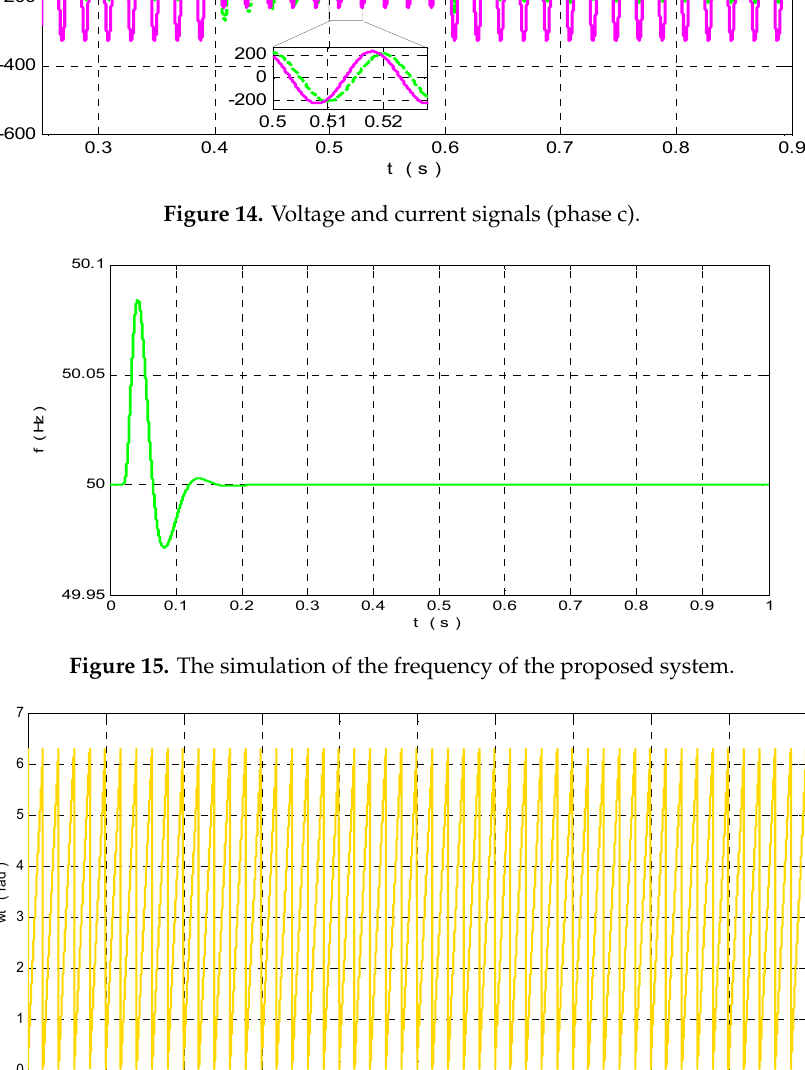
Figure 16. The result simulation of wt.